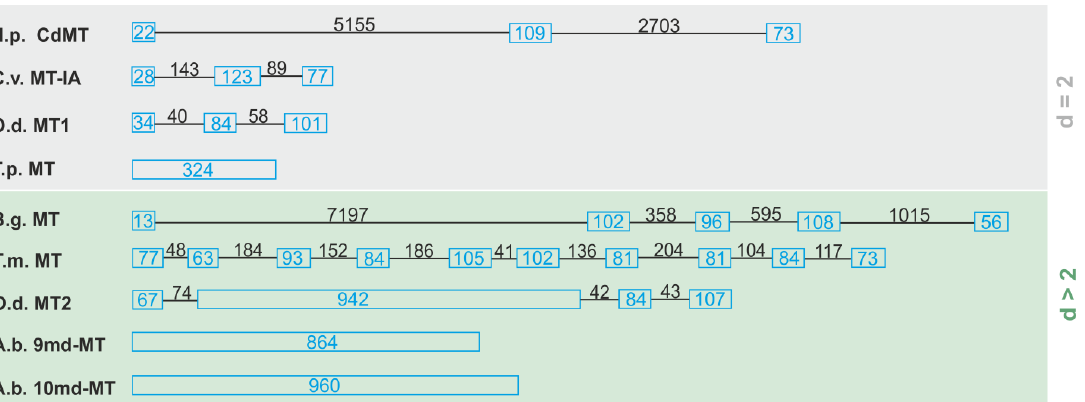
Figure 3. Outline of different gene structures of two (d = 2) and multi-domain (d > 2) MTs. Blue boxes represent the exons, introns are symbolized by lines. The exact length of exons and introns is given in bp (blue for exons, black for introns). Species abbreviations and references (in brackets) are as follows: O.d., Oikopleura dioica [47]; H.p., Helix pomatia [13]; B.g., Biomphalaria glabrata [48]; A.b., Alinda